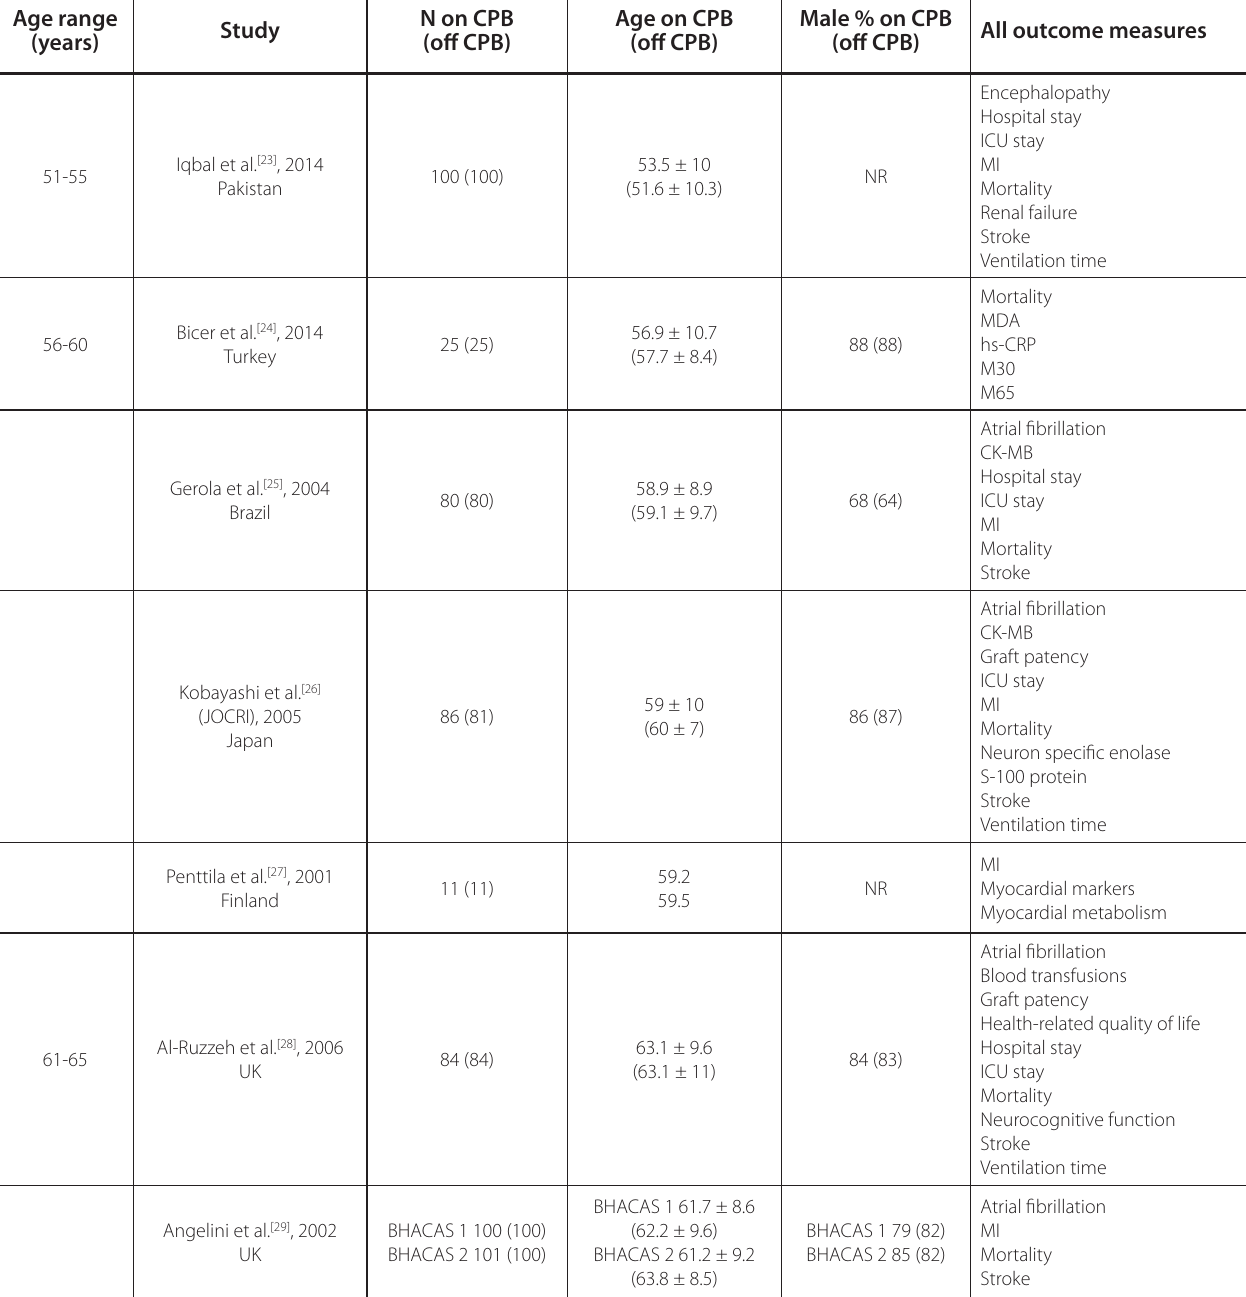
Table 1 . Characteristics of the included